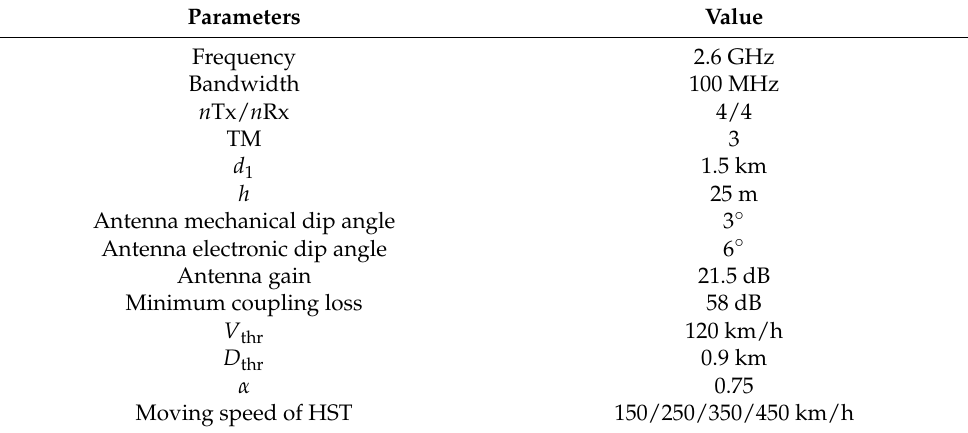
Table 2. Configuration of parameters.